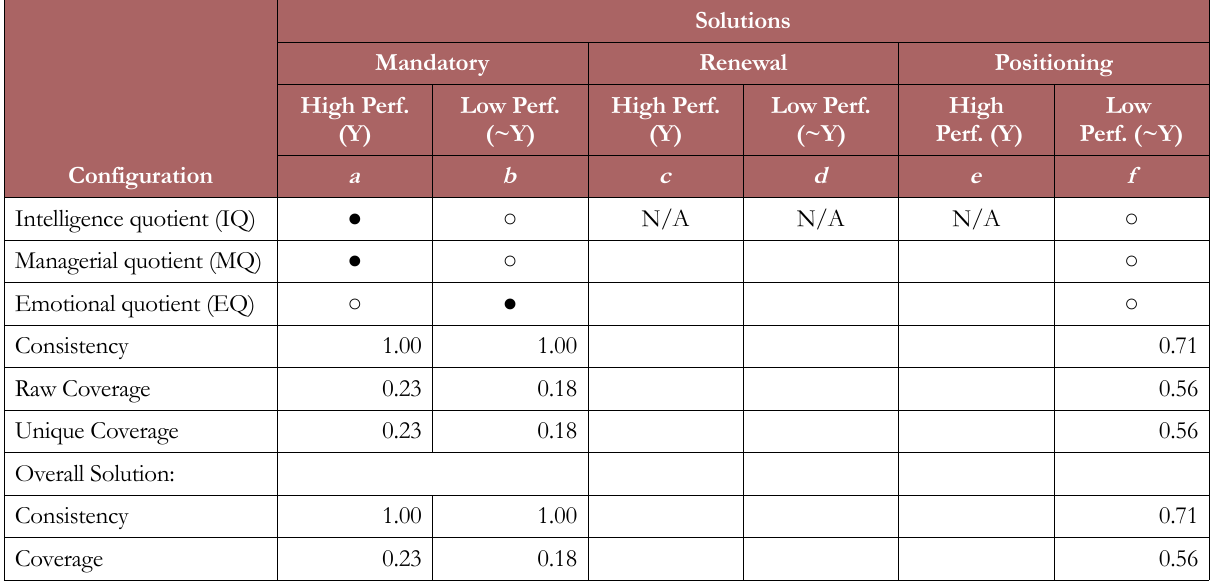
Table 14 The Leadership Configuration Table across Three Strategic